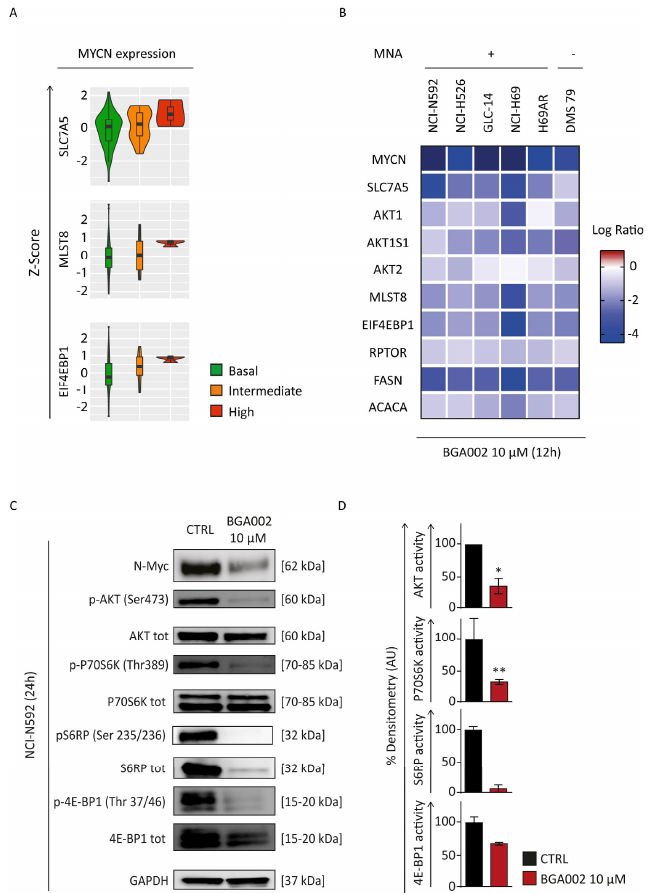
Figure 3. BGA002 leads to mTOR complex inhibition in SCLC cell lines. ( A ) Violin plot reporting SLC7A5 , MLST8 and EIF4EBP1 Z − Score in SCLC patients grouped by MYCN expression level. ( B ) Heat map of the mTOR pathway-related gene expression variation after 12 h of BGA002 treatment (10 μ M) in small-cell lung cancer cell lines. Columns represent cell lines, rows represent genes belonging to the mTOR pathway and the color scale represents the log2 fold change in comparison with the untreated cells (n = 3 for each cell line). ( C ) Western blot analysis for mTOR pathway activity in NCI-N592 cell line after 24 h of treatment (representative image of one of the two biological replicates). The original western blots is shown in File S2. ( D ) mTOR pathway activity quantification, normalized over the control (n = two experiments). The bars represent the mean, and the whiskers are the standard deviation. Data are analyzed with a two − tailed Student’s t − test: *, p ≤ 0.05; **, p ≤ 0.01; where not indicated p − value > 0.05.